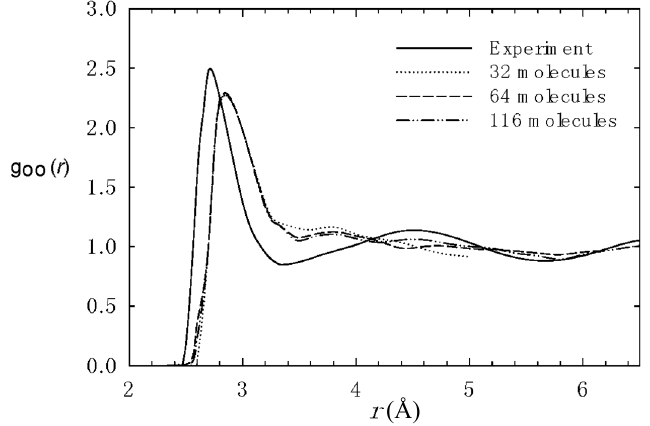
Figure 1. O-O radial distribution function (RDF) for liquid water at 298 K. The ambient pressure experimental data is from [24], whilst results for the three different system sizes are presented for DRSLL.